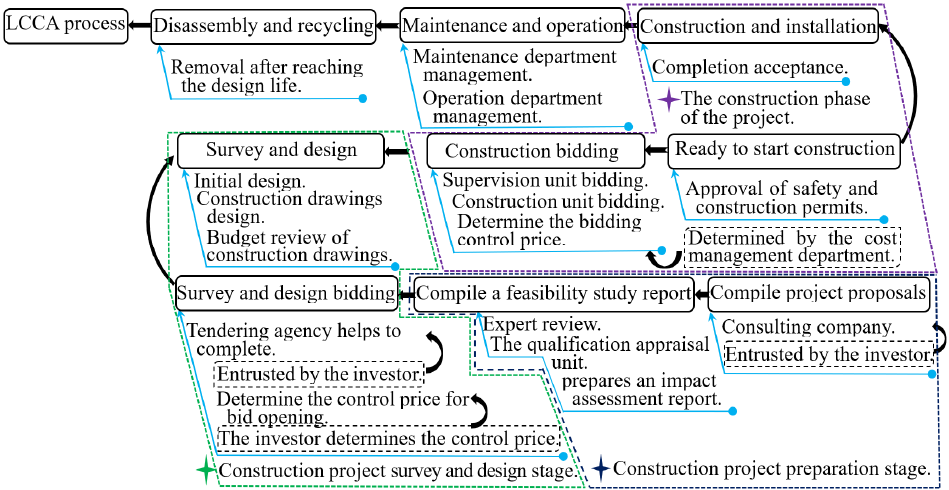
Figure 1. Basic procedure flow chart of highway engineering construction.